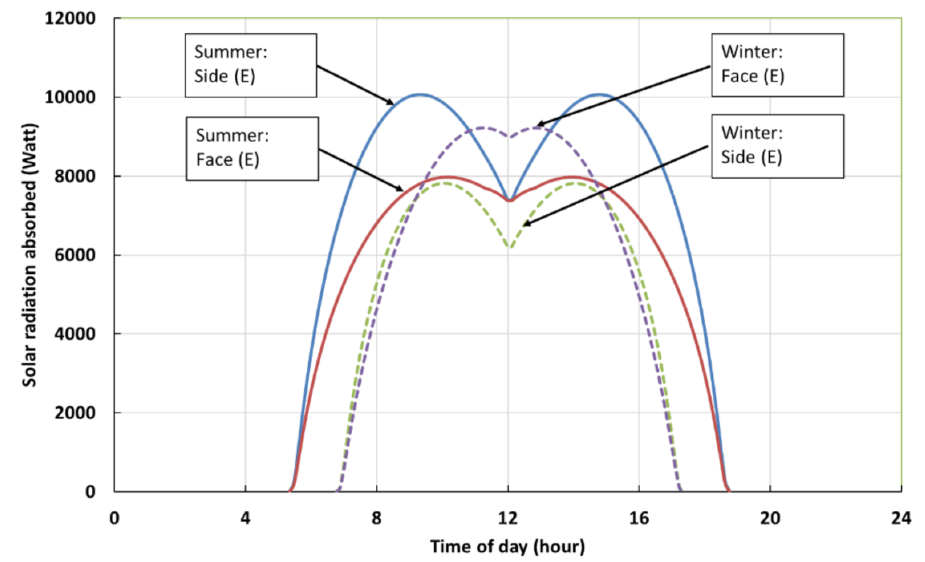
Figure 13. Solar radiation absorbed by the container in mid-summer and mid-winter for orthogonal orientations. Side (E) indicates the container side wall normal to the east, Side (W) indicates the container side wall normal to the west, Face (N) indicates the container face wall normal to the north, Face (S) indicates the container face normal to the south, and Roof indicates the roof wall of the container, which is normal to up.